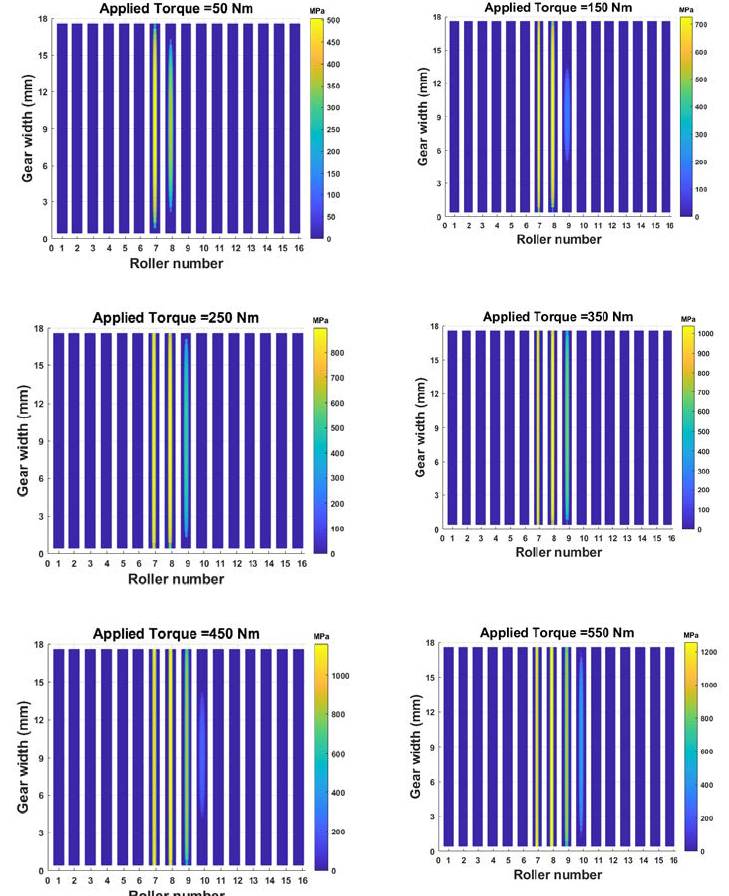
Figure 13. Contact stresses and contact patterns of the NNM and LCM cycloid gear pair under applied torque values of 50, 150, 250, 350, 450, and 550 Nm. torque values of 50, 150, 250, 350, 450, and 550